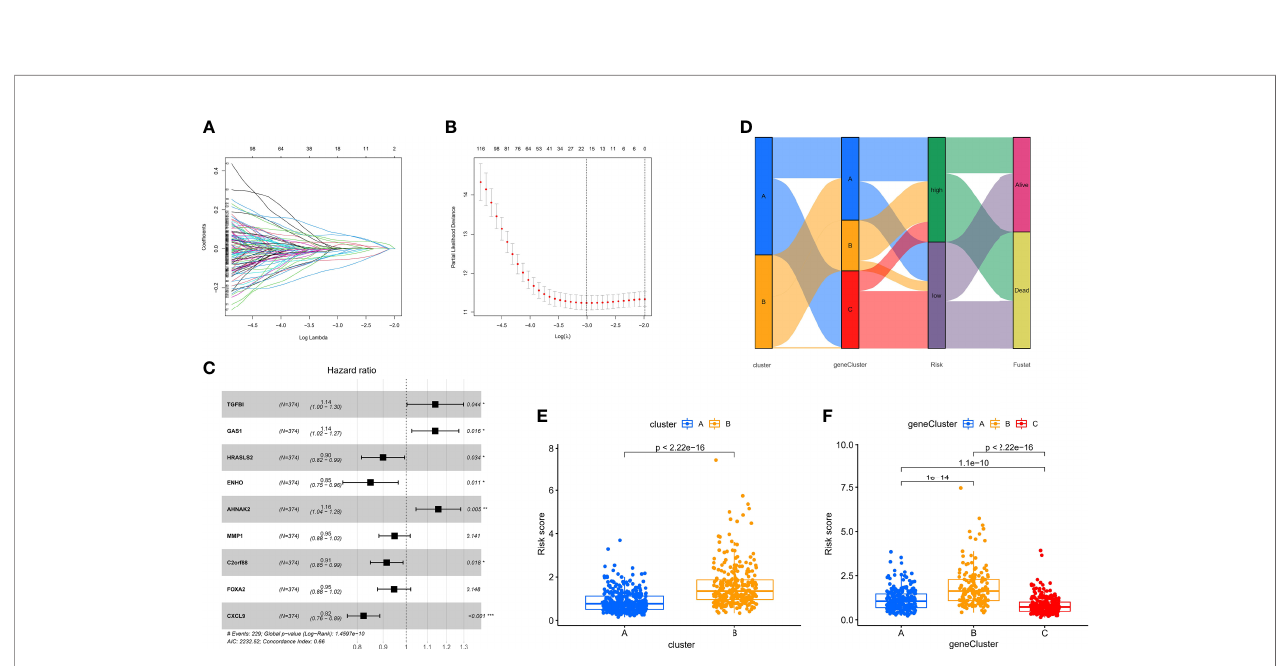
FIGURE 6 | Identi fi cation of the nine-gene next-generation sequencing panel. (A, B) Determination of the number of regulators using LASSO analysis. (C) Forest plot of multivariate Cox regression analysis. (D) Sankey diagram of the three types of subtypes. (E) Analysis of differences in hypoxia risk score of different hypoxia patterns. (F) Analysis of differences in hypoxia risk score of different hypoxia pattern-related regulator subtypes.